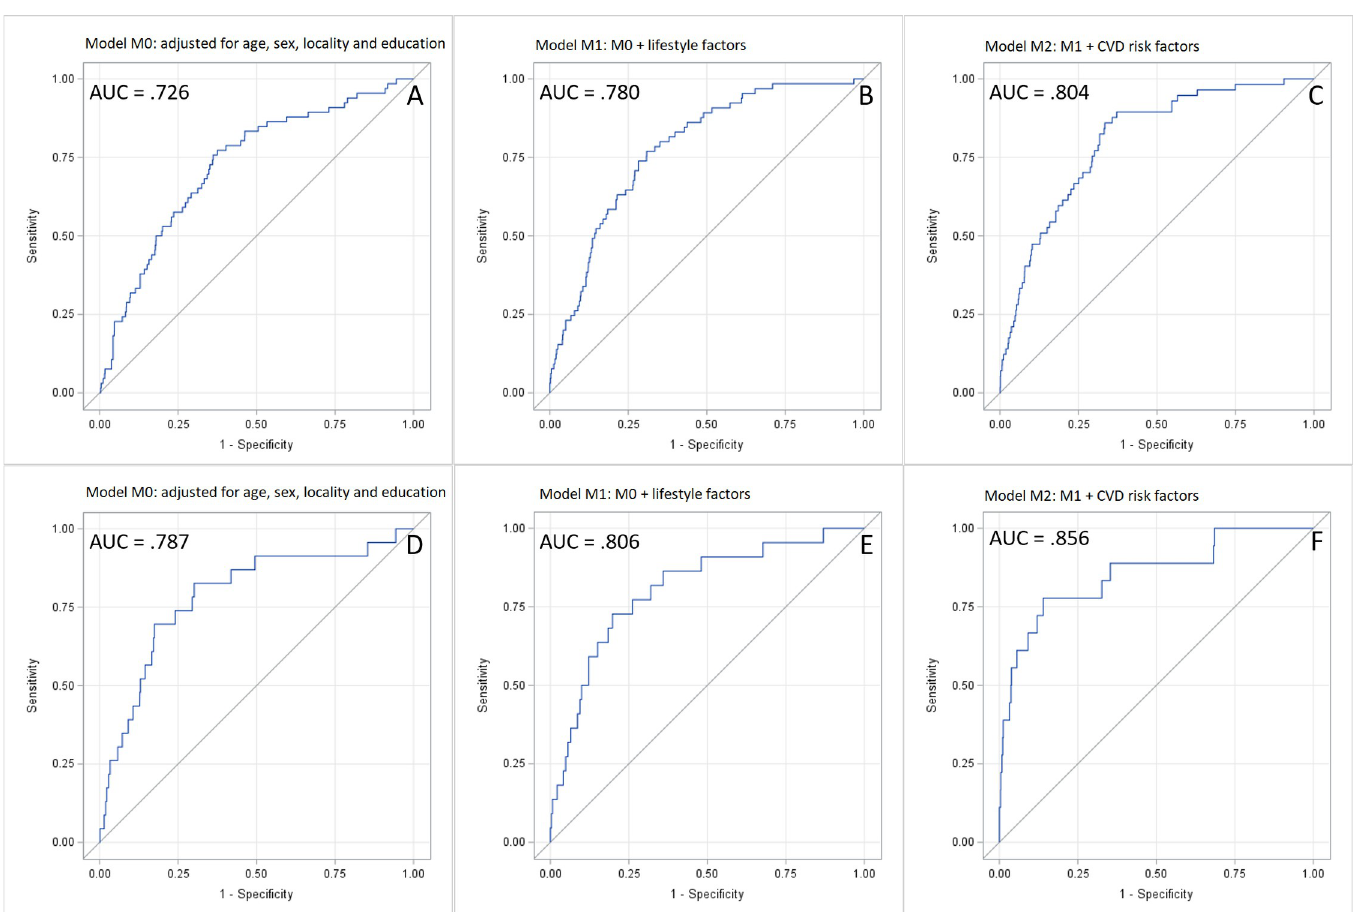
Fig 1. ROC curve of risk factors related to all, non-fatal and fatal CV outcomes. M0 (panels A and D): model of age, sex, locality and education; M1 (panels B and E): M0 supplementary adjusted for lifestyle (merged current smoking and alcohol use and weighted physical activity index); M2 (panels C and F): M1 supplementary adjusted for CVD risk factors (Framingham risk score and hypertension) and biochemical